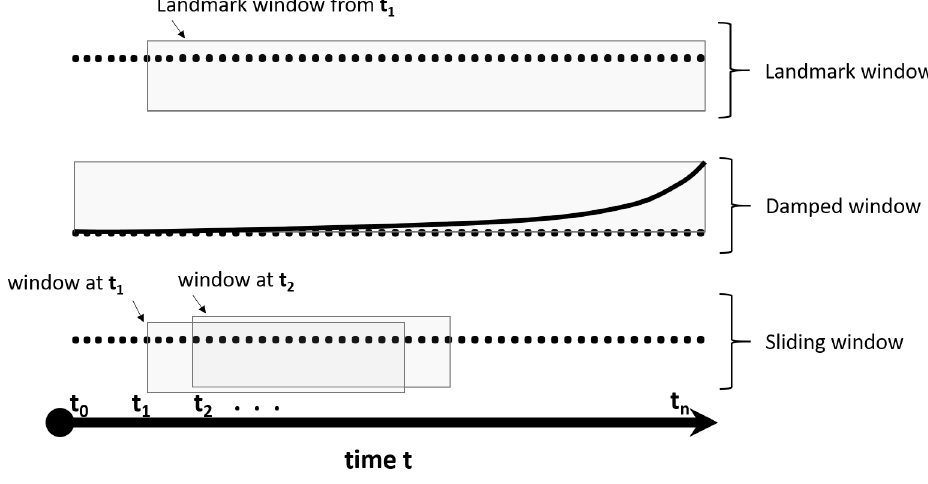
Figure 1. Overview of Windowing approaches to induce data mining models from streamining